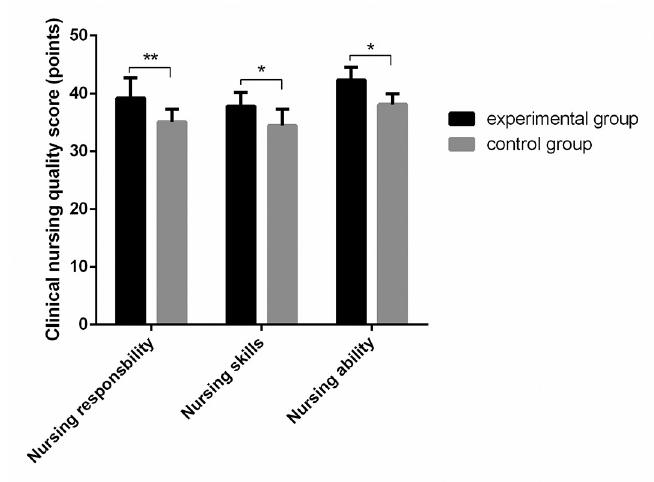
Figure 2. Between group comparison of clinical nursing quality. Note: ** There were significant differences in nursing responsibility between the two groups ( P < 0.05); ∗ indicates that there were significant differences in nursing skills between the two groups ( P < 0.05); * There were significant differences in nursing ability between the two groups ( P < 0.05).